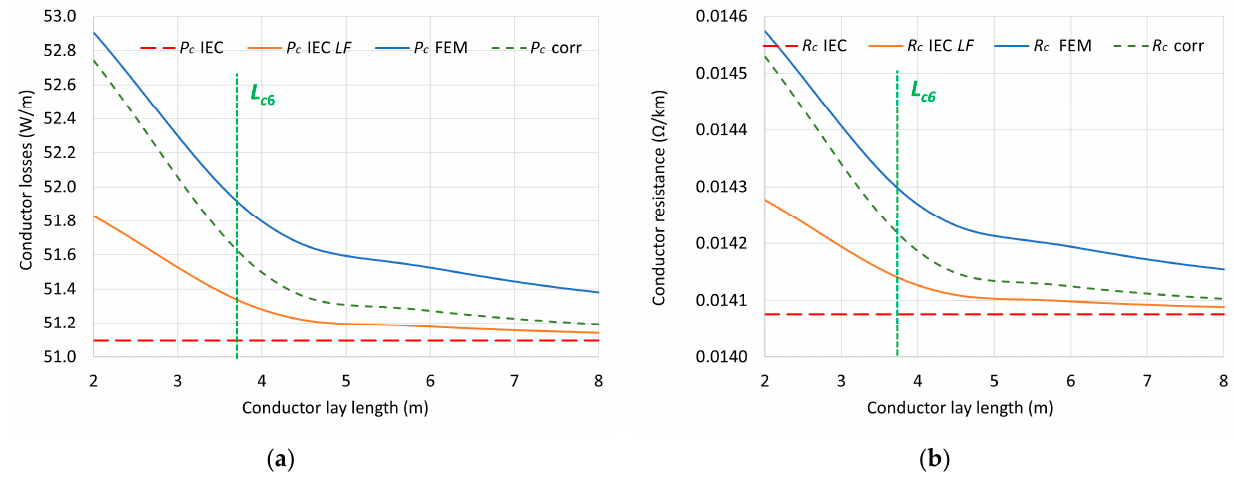
Figure 8. Conductor ( a ) losses and ( b ) resistance for Cable 6 with neither armor nor sheaths (20 °C). As recommended in [29], the additional length of the conductor due to the twisting of the phases should be considered in the analytical computation of the DC resistance. This is done by multiplying Equation (3) by LF (previously defined in Equation (9)). This